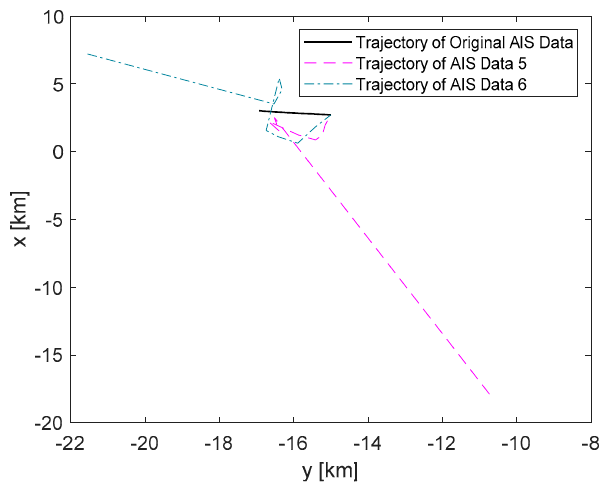
Figure 10. Trajectories of AIS data5 to AIS data 6.